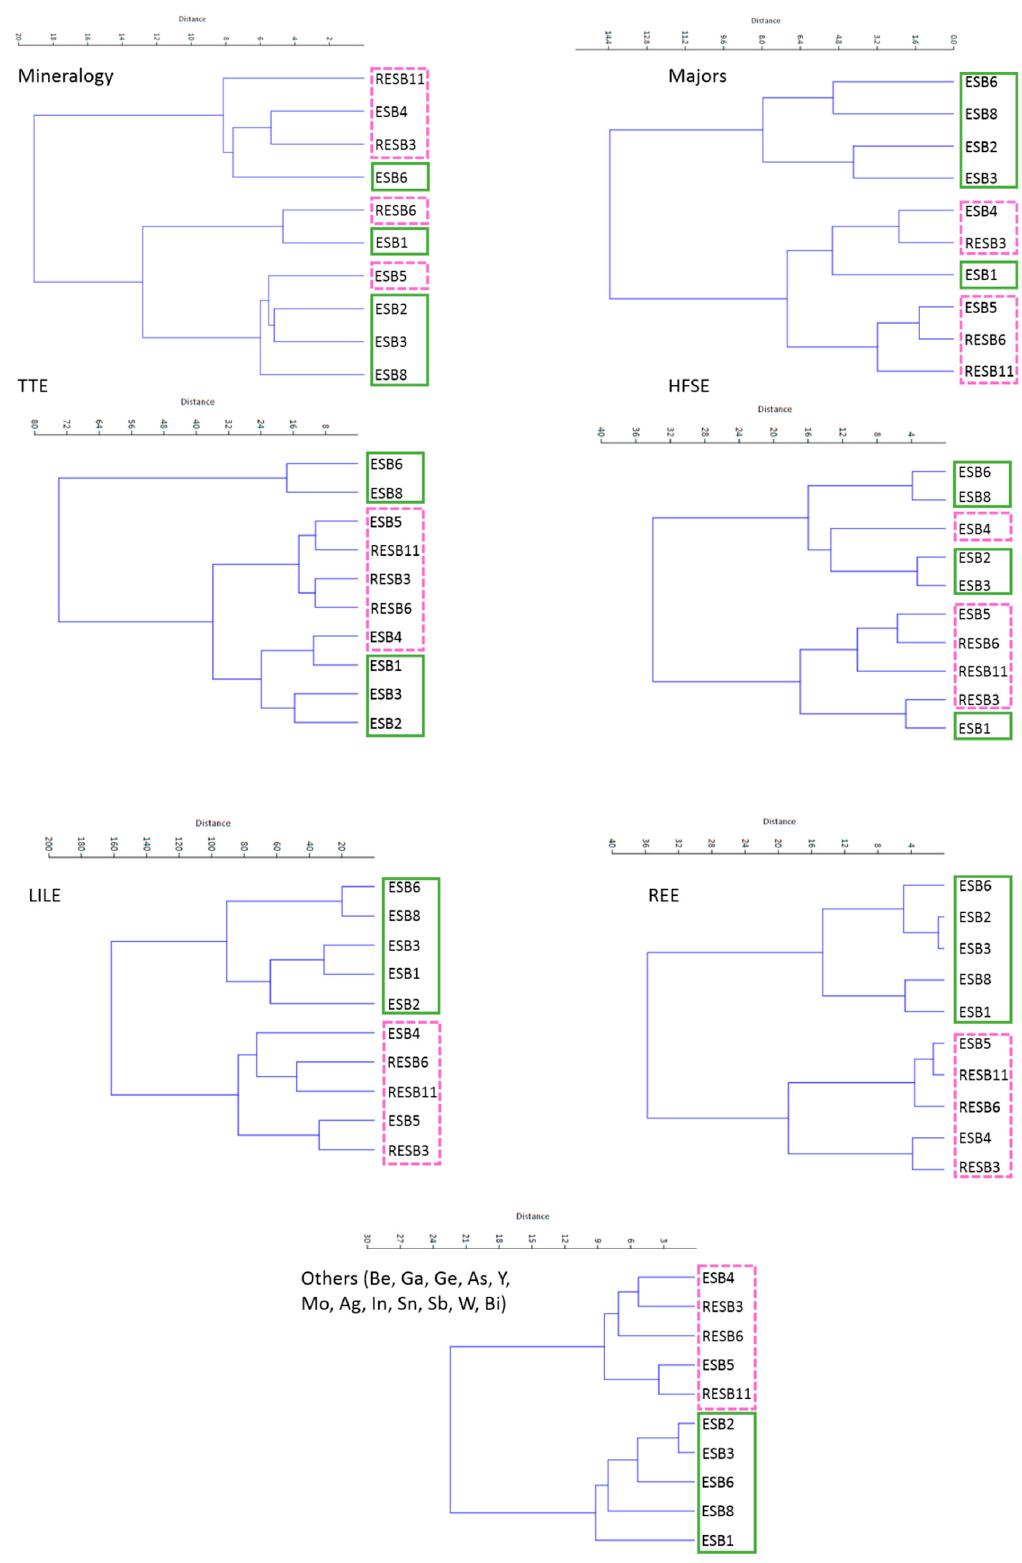
Figure 7. Multivariate clusters of the different elements analyzed for green (continuous line) and pink (discontinuous line) clays.